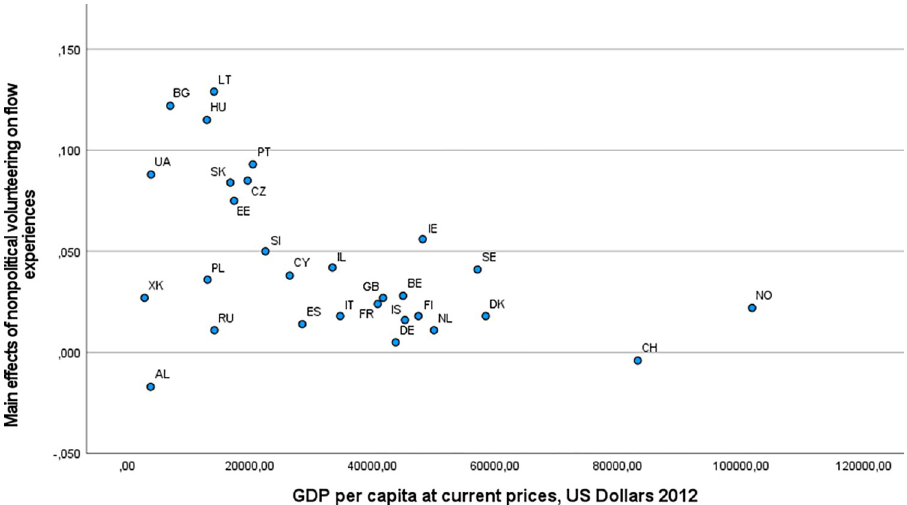
Fig 4. A scatterplot of the main effects of nonpolitical volunteering on flow experiences against GDP per capita.